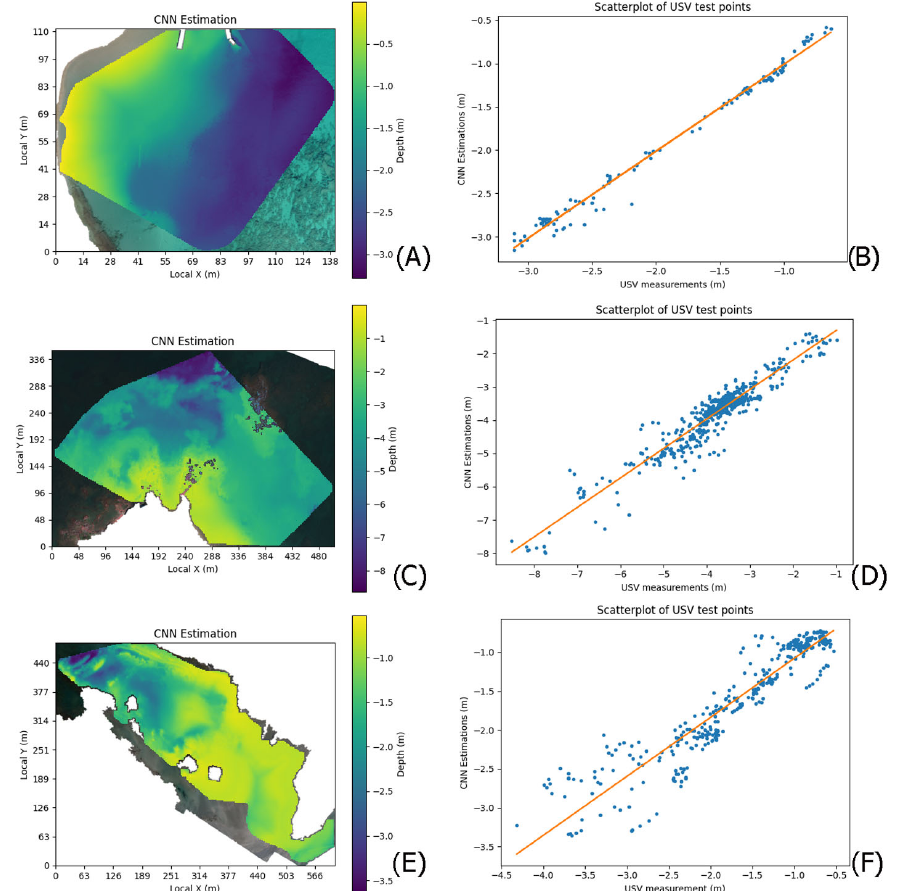
Figure 5. Bathymetry outputs and corresponding scatterplots with USV data. Each CNN model was trained and validated at each area separately (training data = 60%, test data = 40%): ( A , B ) Stavros bay (RMSE = 0.088 m, R 2 = 99.0%), ( C , D ) Kalamaki beach (RMSE = 0.346 m, R 2 = 89.4%), ( E , F ) Elafonisi beach (RMSE = 0.327 m, R 2 = 84.5%).